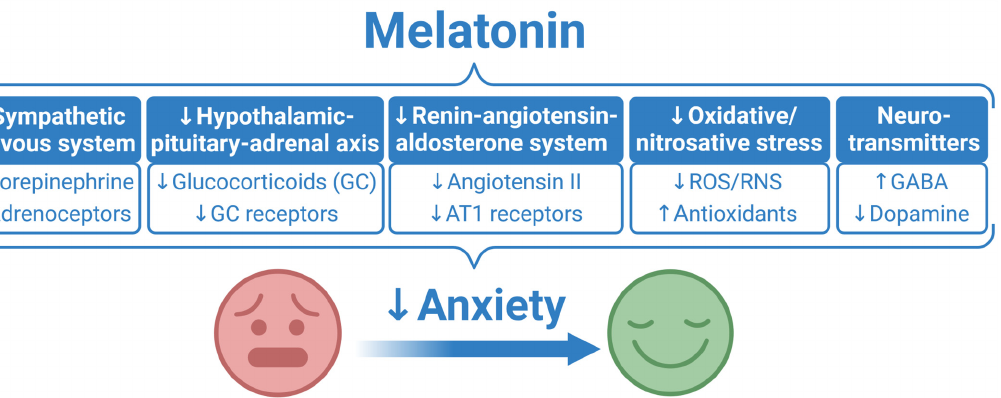
Figure 6. The proposed mechanisms contributing to anxiolytic effect of melatonin. AT1 receptors, angiotensin II type 1 receptors; GABA, γ -aminobutyric acid; GC, glucocorticoids; RNS, reactive ni- trogen species; ROS, reactive oxygen species.